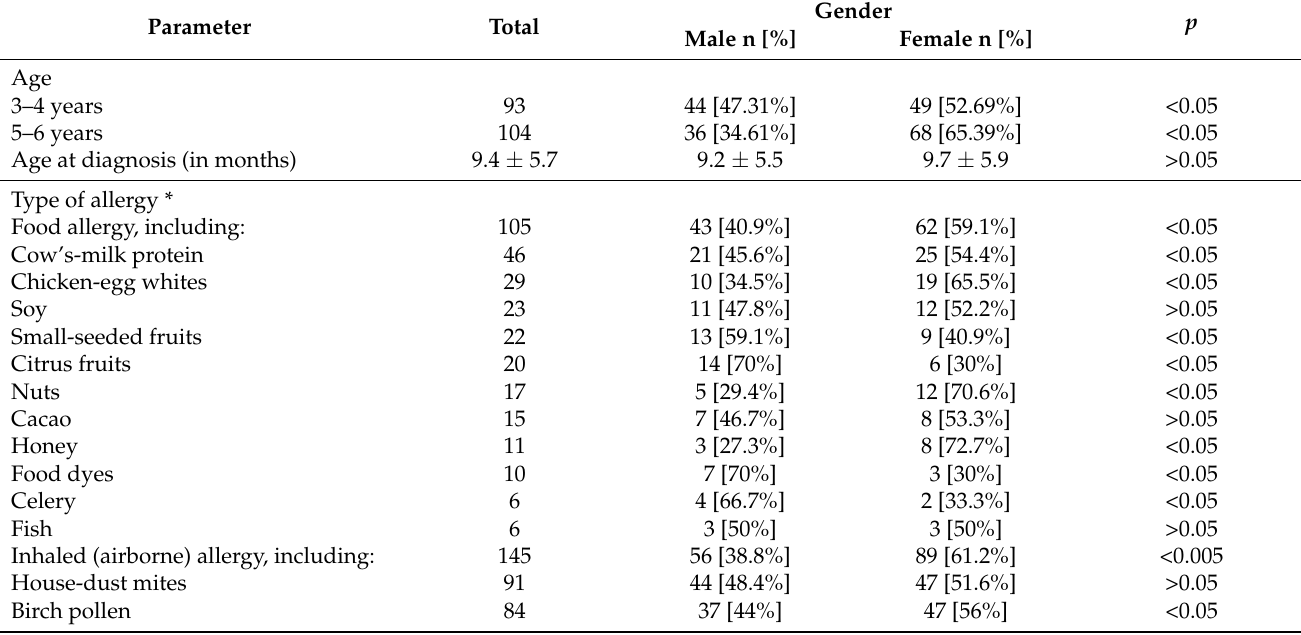
Table 1. Demographic questions concerning children with diagnosed